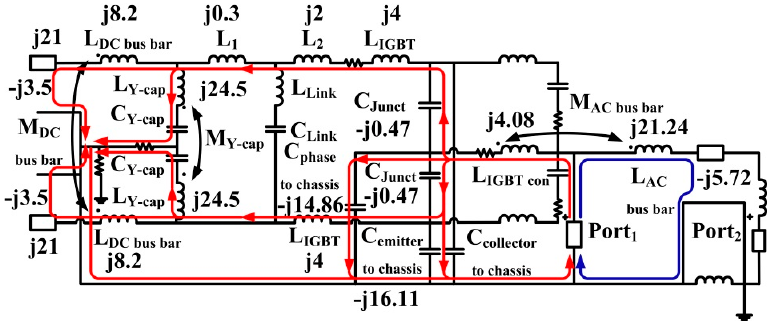
Figure 9. Current ‐ following path at 26 MHz. Figure 9. Current-following path at 26